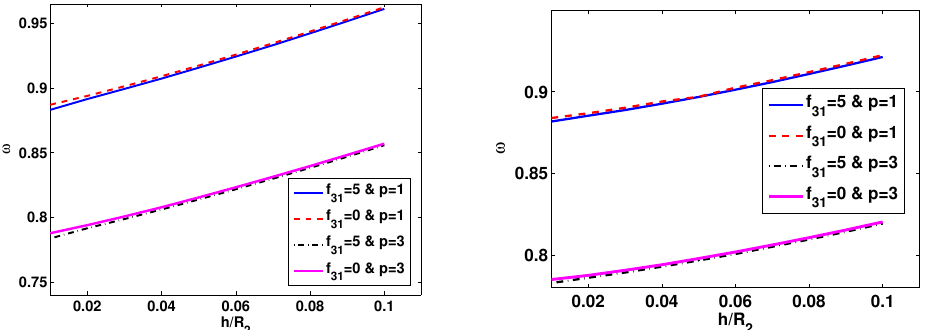
Figure 5. The effect of volume fraction coefficient and flexoelectric term on the frequency of FGM conical nanoshells ( α = 30, k p = 1 × e − 3 , k w = 10 × e 12 , h p / h = 0.1, ( left ) clamped-clamped boundary conditions, ( right ) clamped-simply boundary